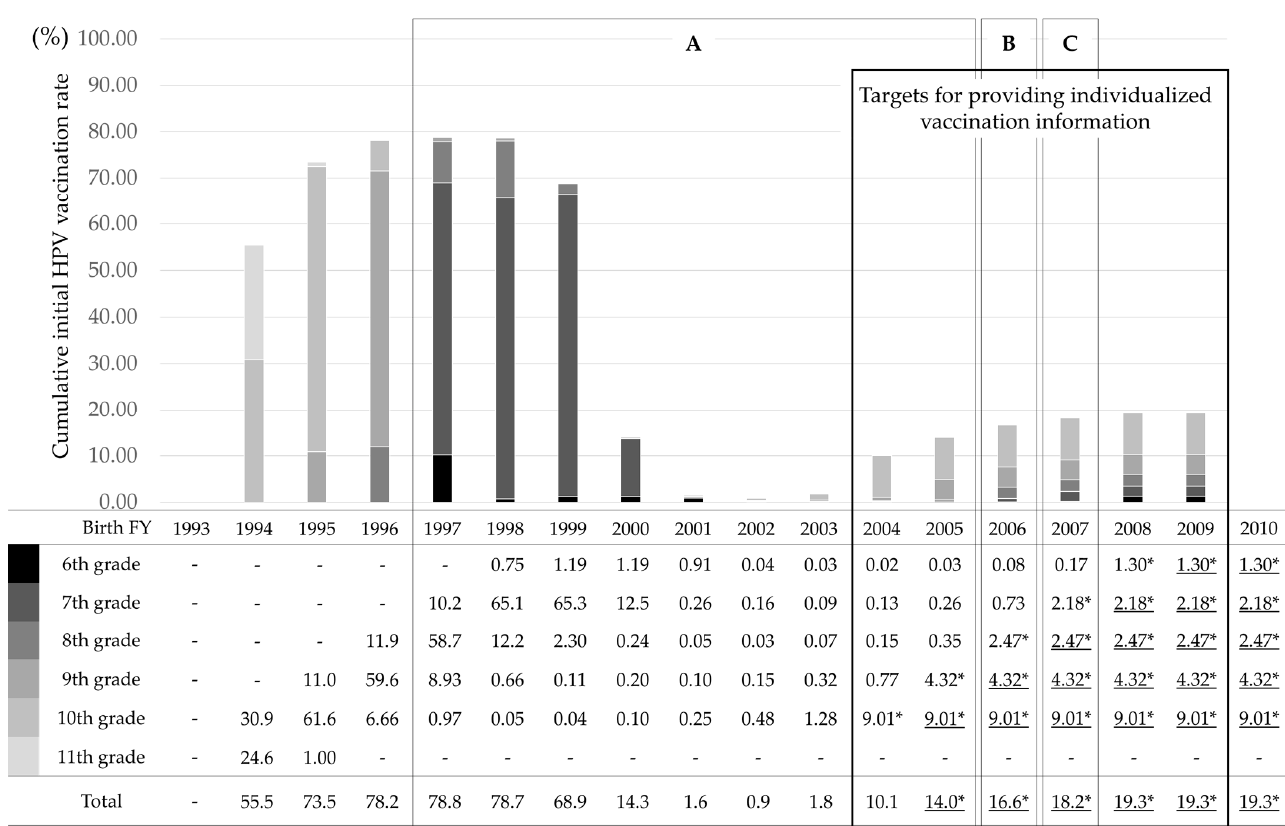
Figure 1. Cumulative initial HPV vaccination rate by birth year and estimated HPV vaccination rates when there was no resumption of governmental recommendation nor catch-up vaccination, and only individual notification provided by mailing. *: Calculated from a survey of municipalities in Osaka Prefecture and the national census. Underline: HPV vaccination rate of the first dose used